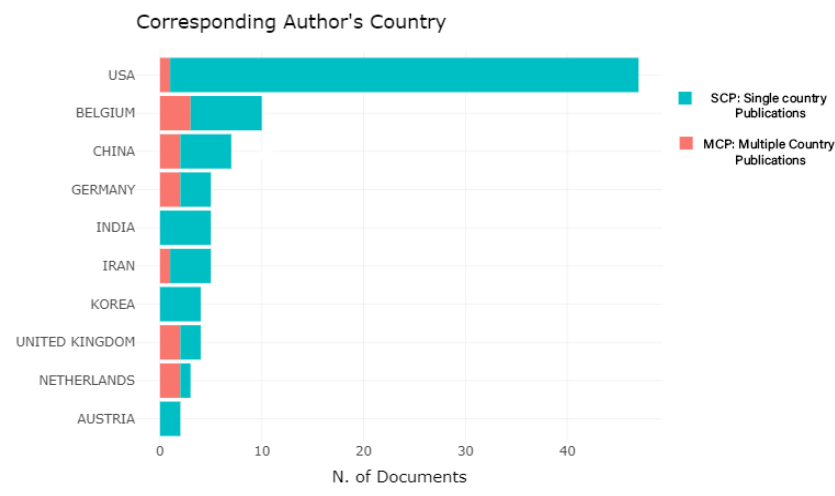
Figure 7. Most productive countries for ankle/foot prosthesis literature.